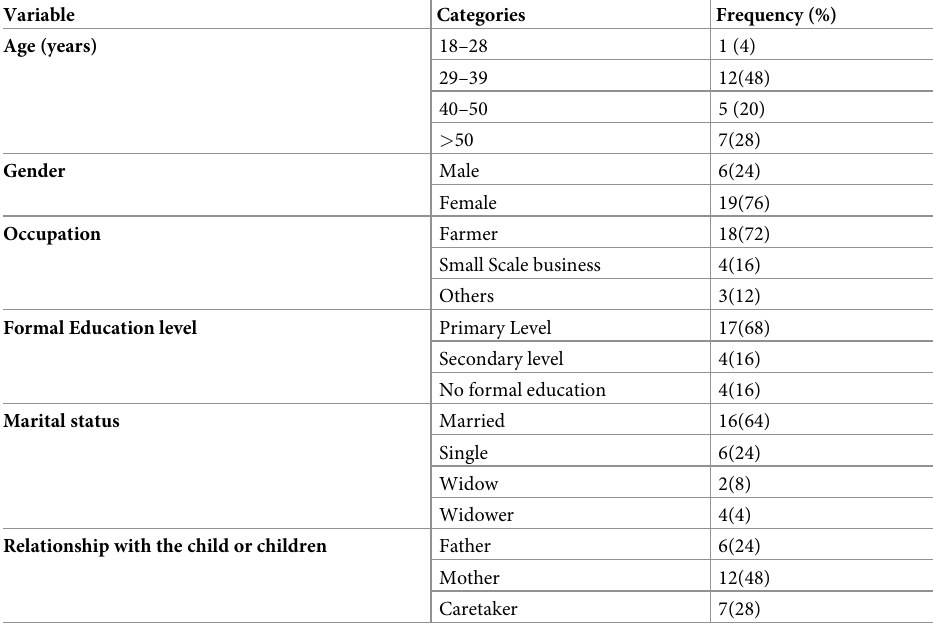
Table 1. Demographic characteristics of the participants (n =